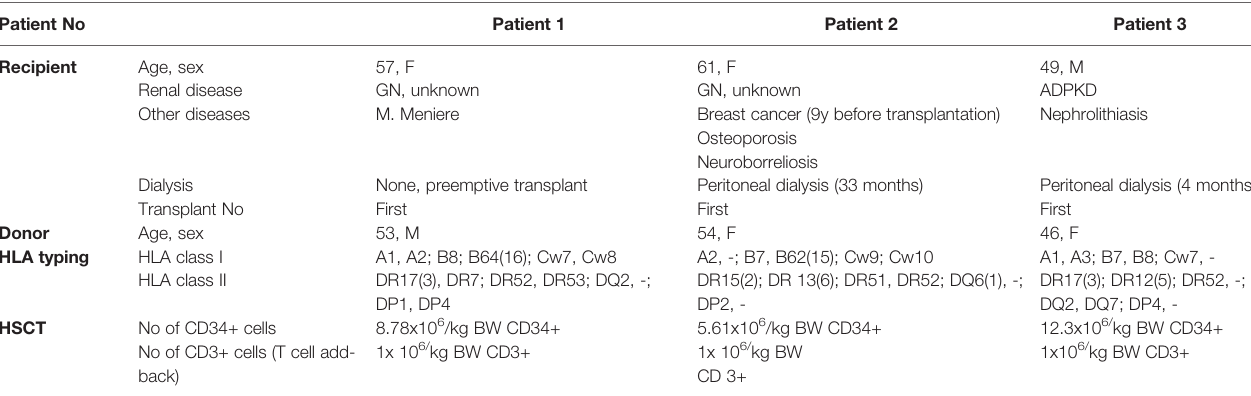
TABLE 1 | Patient and transplant